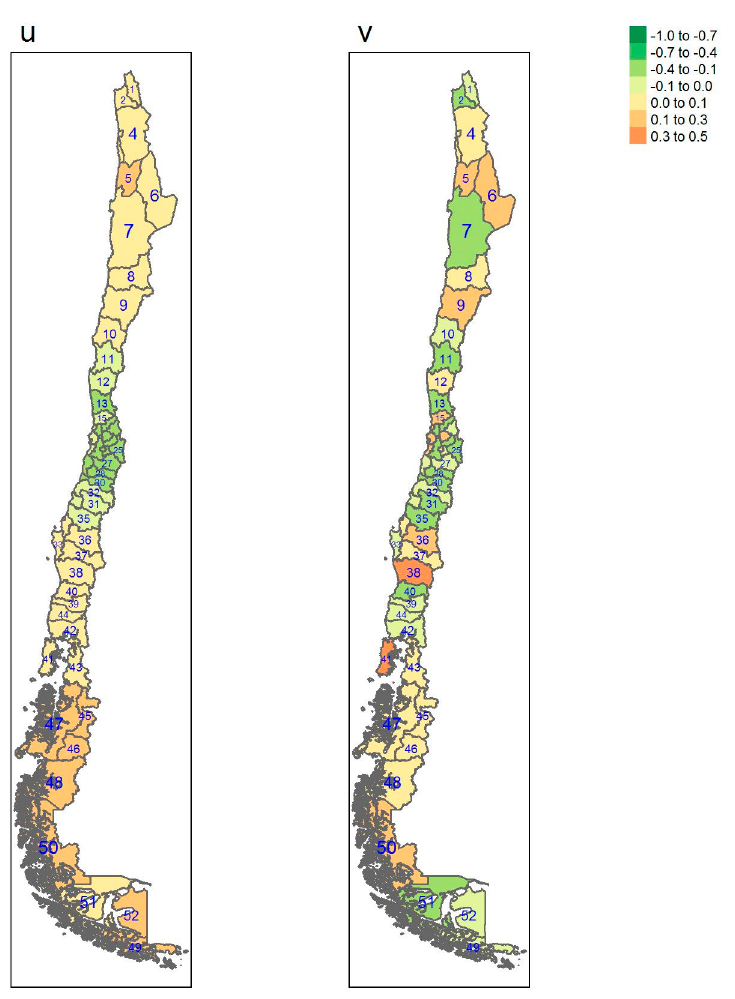
Figure 4. Multi-scale model heterogeneity effects for elevated LDL (u: correlated effect; v: uncorrelated effect).